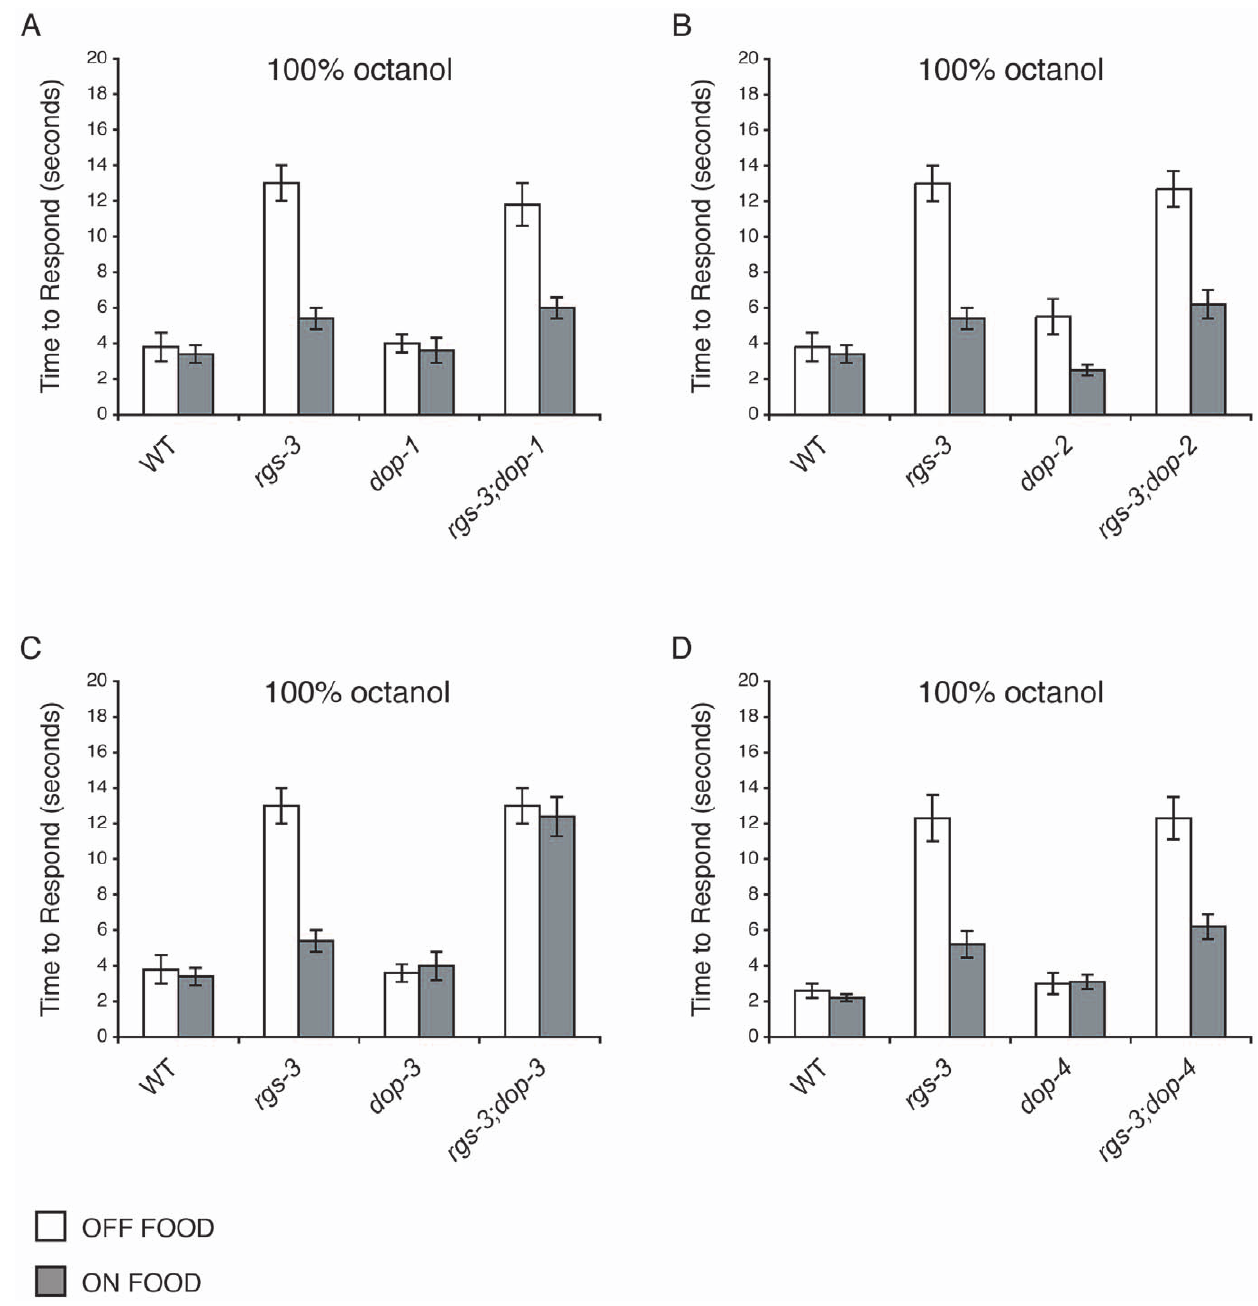
Figure 1. DOP-3 is required for the ‘‘on food’’ rescue of rgs-3 octanol avoidance. Food (OP50 E. coli ) restores the avoidance response of rgs- 3 mutant animals to 100% octanol. Loss-of-function mutations in (A) dop-1 , (B) dop-2 and (D) dop-4 had no effect on the ‘‘on food’’ rescue of rgs-3 octanol avoidance (p . 0.2 for each when compared to the rgs-3 on food response). (C) Loss of DOP-3 function blocked the ‘‘on food’’ rescue of rgs-3 octanol avoidance (p # 0.0001 when compared to rgs-3 on food). Alleles used: rgs-3(vs19) , dop-1(vs101) , dop-2(vs105) , dop-3(vs106) and dop-4(tm1392) . WT = the N2 wild-type strain. The time to respond is shown. n $ 32. Error bars represent the standard error of the mean (SEM). doi:10.1371/journal.pone.0009487.g001 animals do not completely lack endogenous DA (they still synthesize , 40% of wild-type C. elegans DA levels), this is similar to what is seen in tyrosine hydroxylase-deficient mice [35,37]. cat-2 mutant animals are hypersensitive and respond better than wild- type animals to dilute concentrations of octanol [13,18]. In addition, animals lacking three DA receptors ( dop-2;dop-1dop-3 triple mutants) are hypersensitive to dilute octanol [18]. The